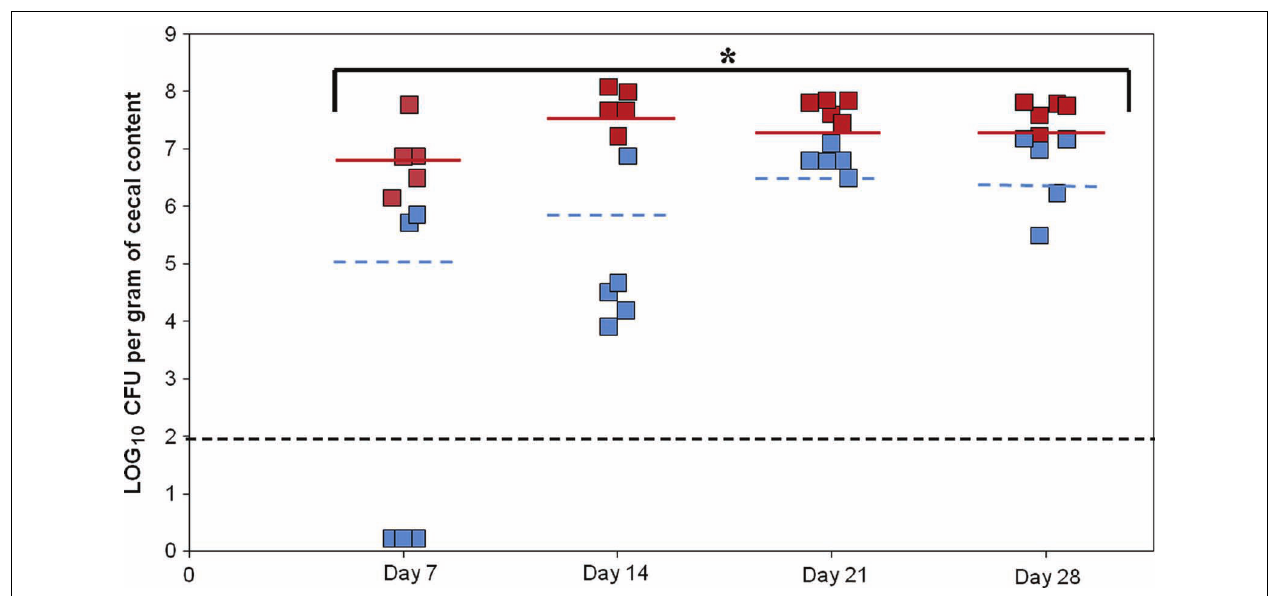
FIGURE 5 | Effect of the PNPase mutation on chick gut colonization by C. jejuni . The experiment included three groups of birds.Two days old chicks were orally gavaged with 1.4 to 1.5 × 10 7 CFU of C. jejuni 81-176 (red squares) or 81-176 derivative strain lacking production of PNPase (blue squares). Colonization levels were measured by enumeration of bacteria present in ceca on days 7, 14, 21, and 28 post-inoculation (LOG 10 CFU/g of